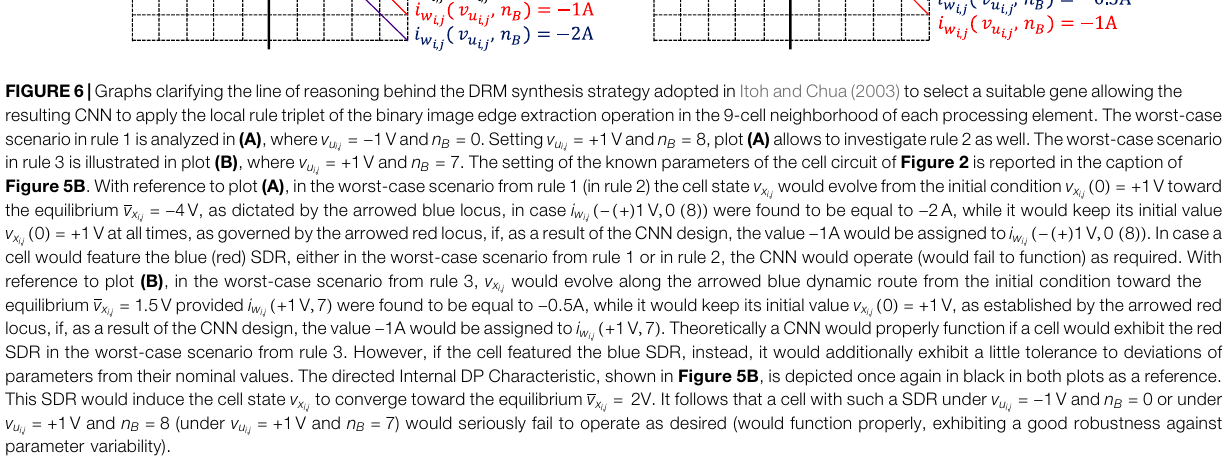
· R · g − G ) · v 0 , 0 y lin x sat ,